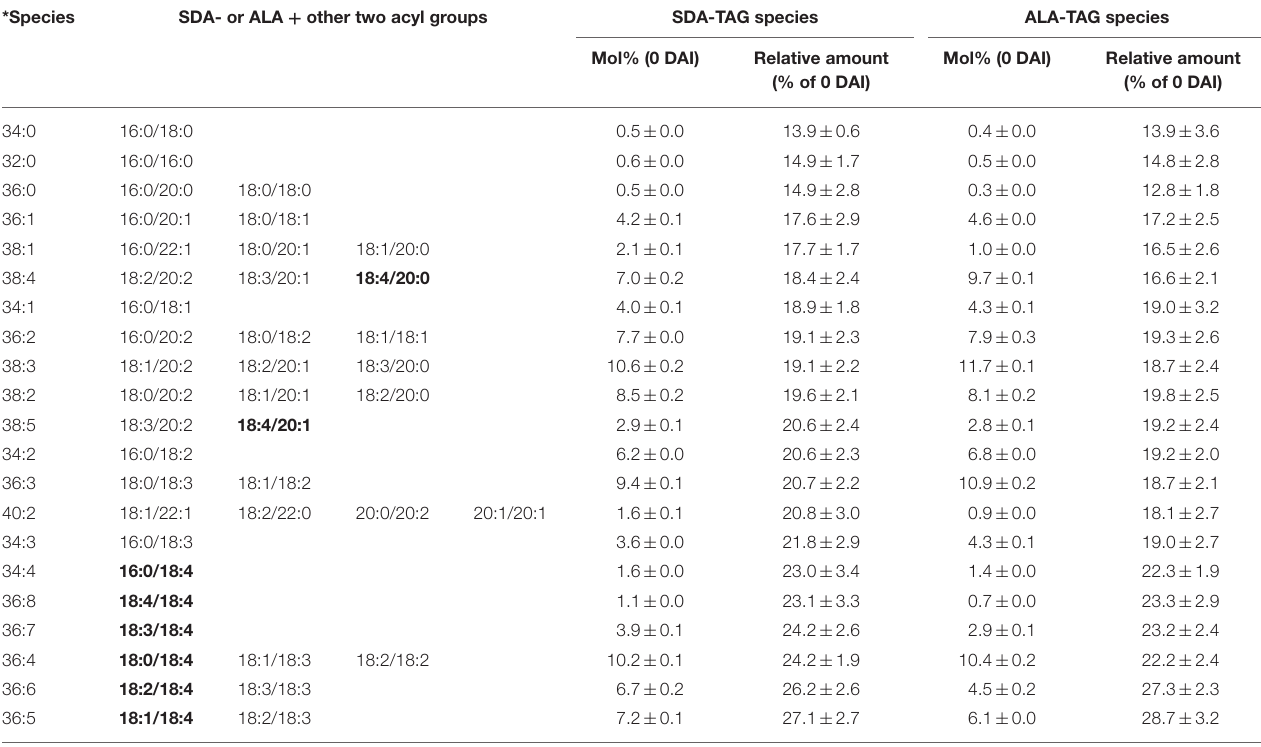
TABLE 3 | Mobilization of SDA- and ALA-containing TAG species on 4 DAI during seedling developments in SDA-line. *Species SDA- or ALA + other two acyl groups SDA-TAG